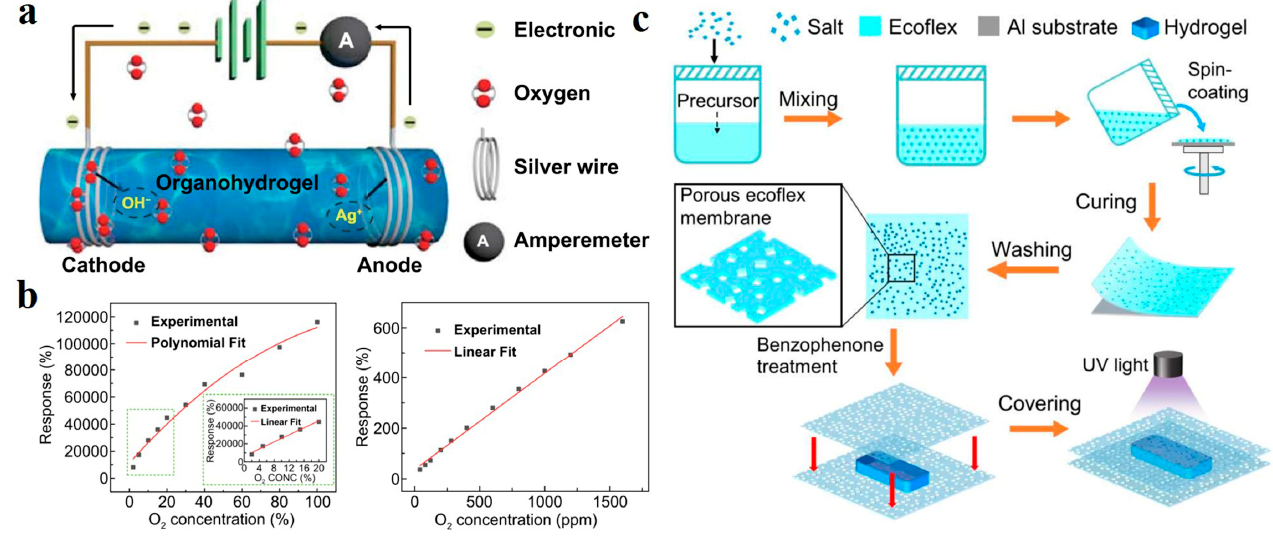
Figure 12. ( a ) The principle of hydrogel sensor. ( b ) The linear relationship between response intensity and oxygen concentration. Reprinted with permission from Ref. [135]. ( c ) Schematic diagram of moisture resistant oxygen sensor assembled on hydrogel surface using ecoflex porous mem-